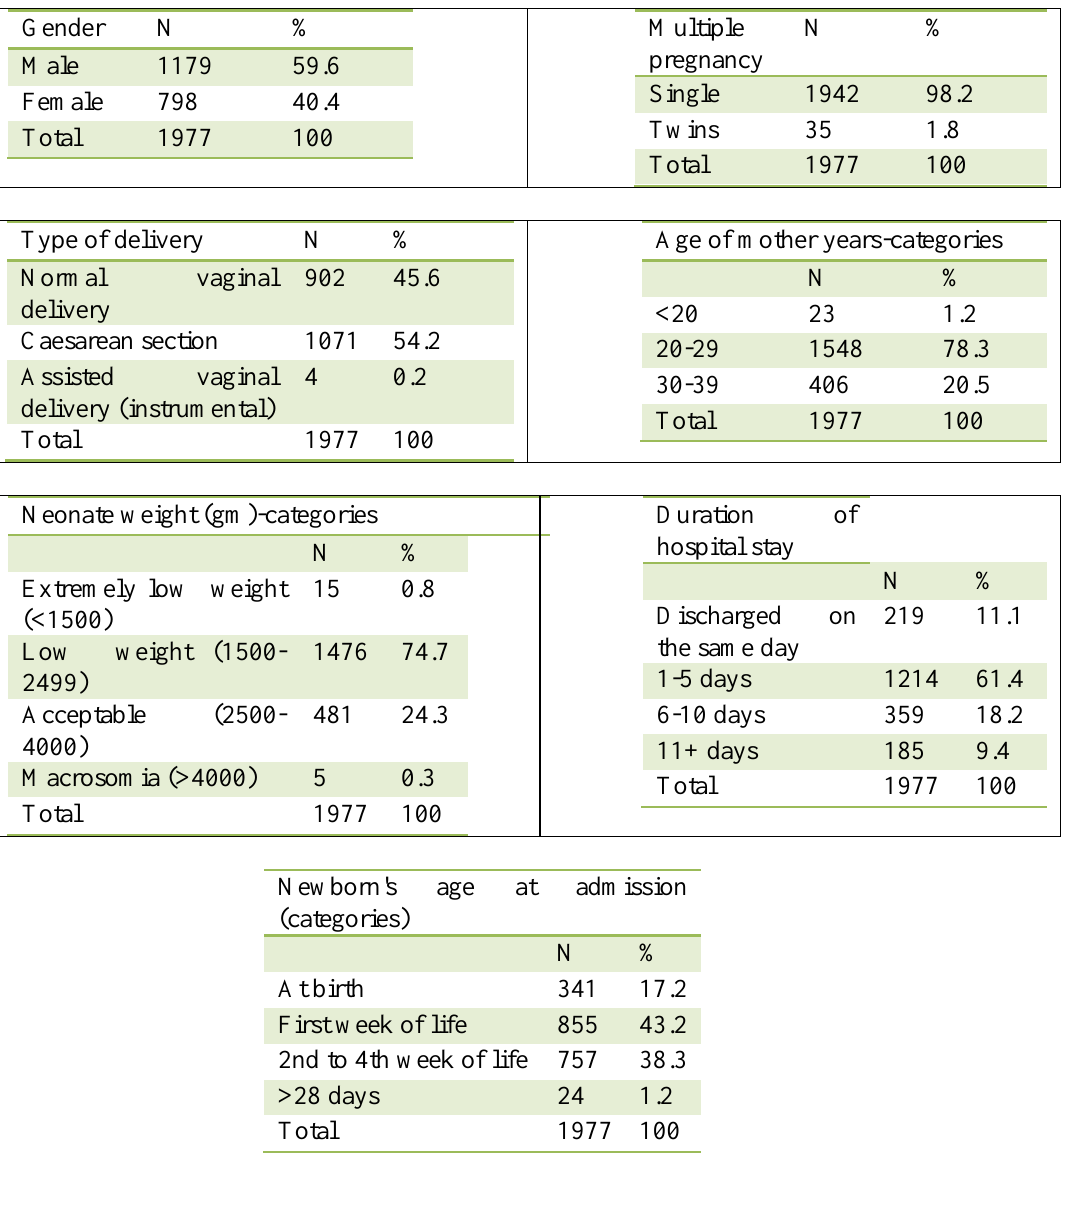
(Table- 1): Frequency distribution of the study sample by socio-demographic